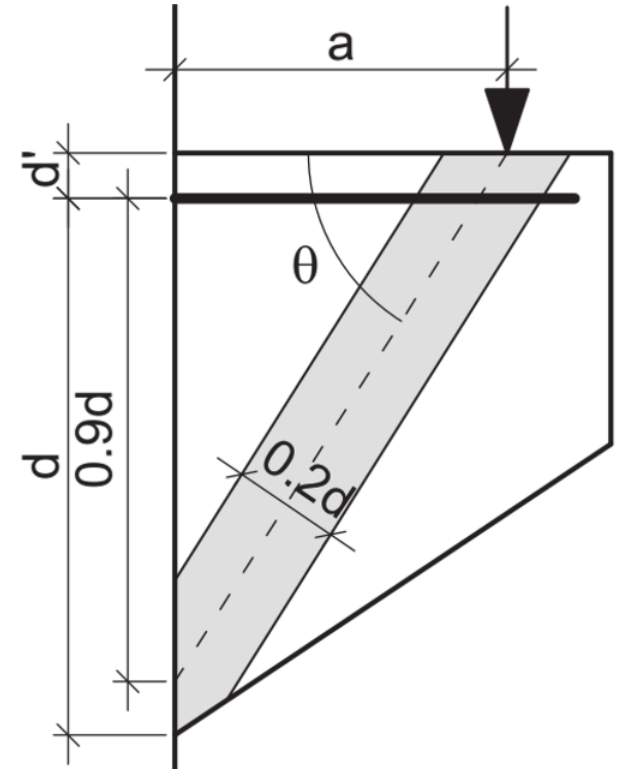
Geometry used for equilibrium of forces and delimitation of the strut width to verify the